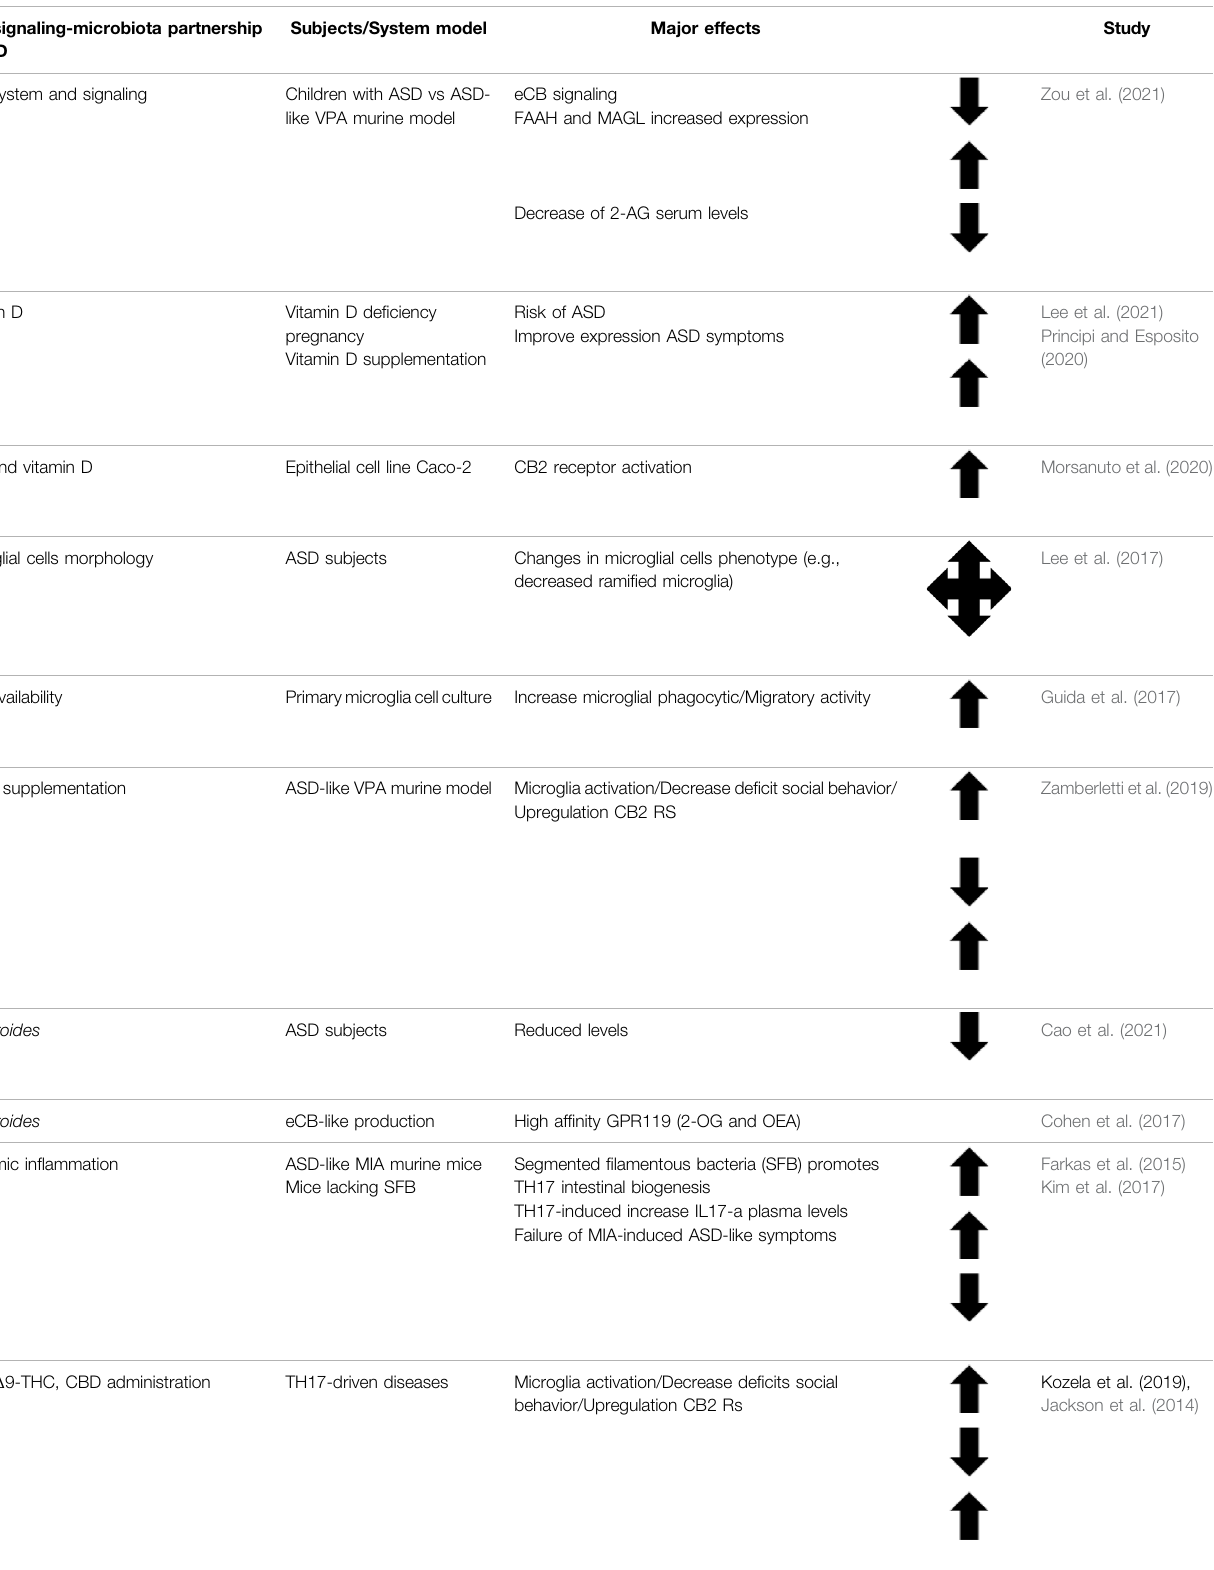
TABLE 2 | ( Continued ) Summary table of the key studies involving eCB signaling and gut microbiota crosstalk in both patients with ASD and ASD-like animal